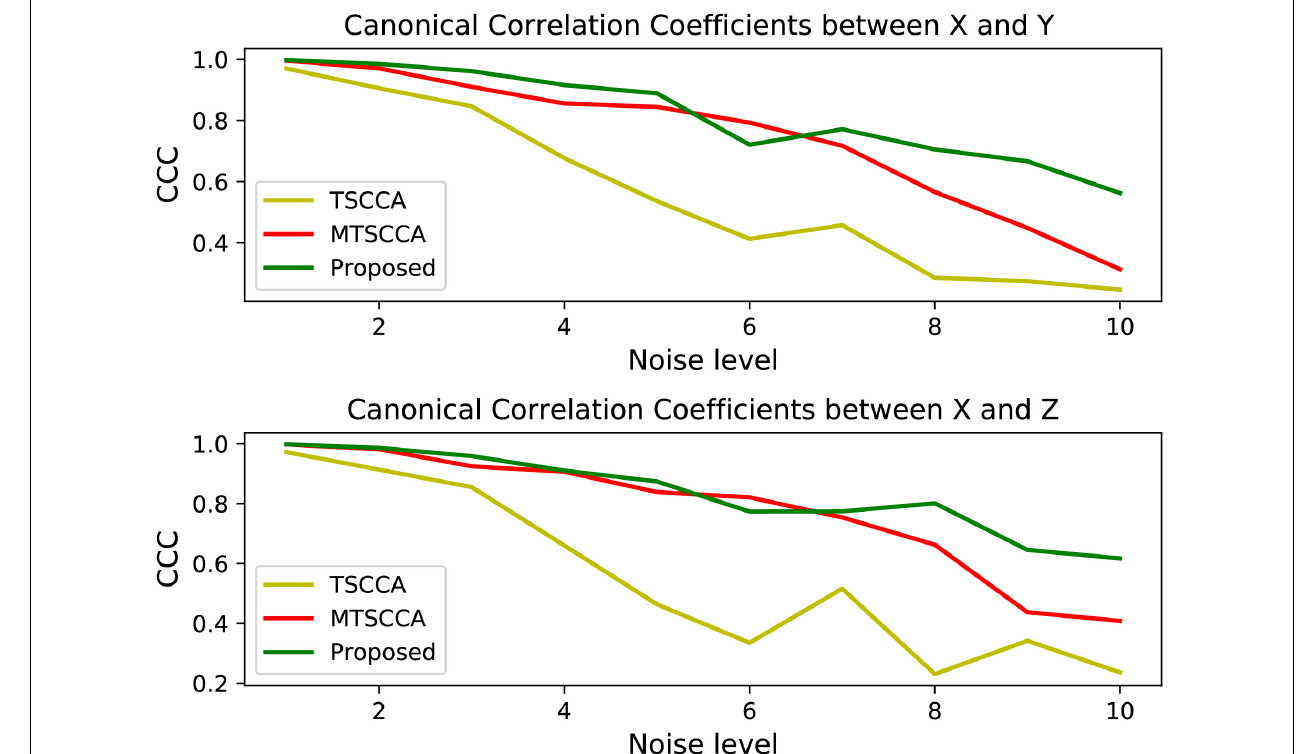
FIGURE 3 | Comparison of CCCs under various noise levels for three